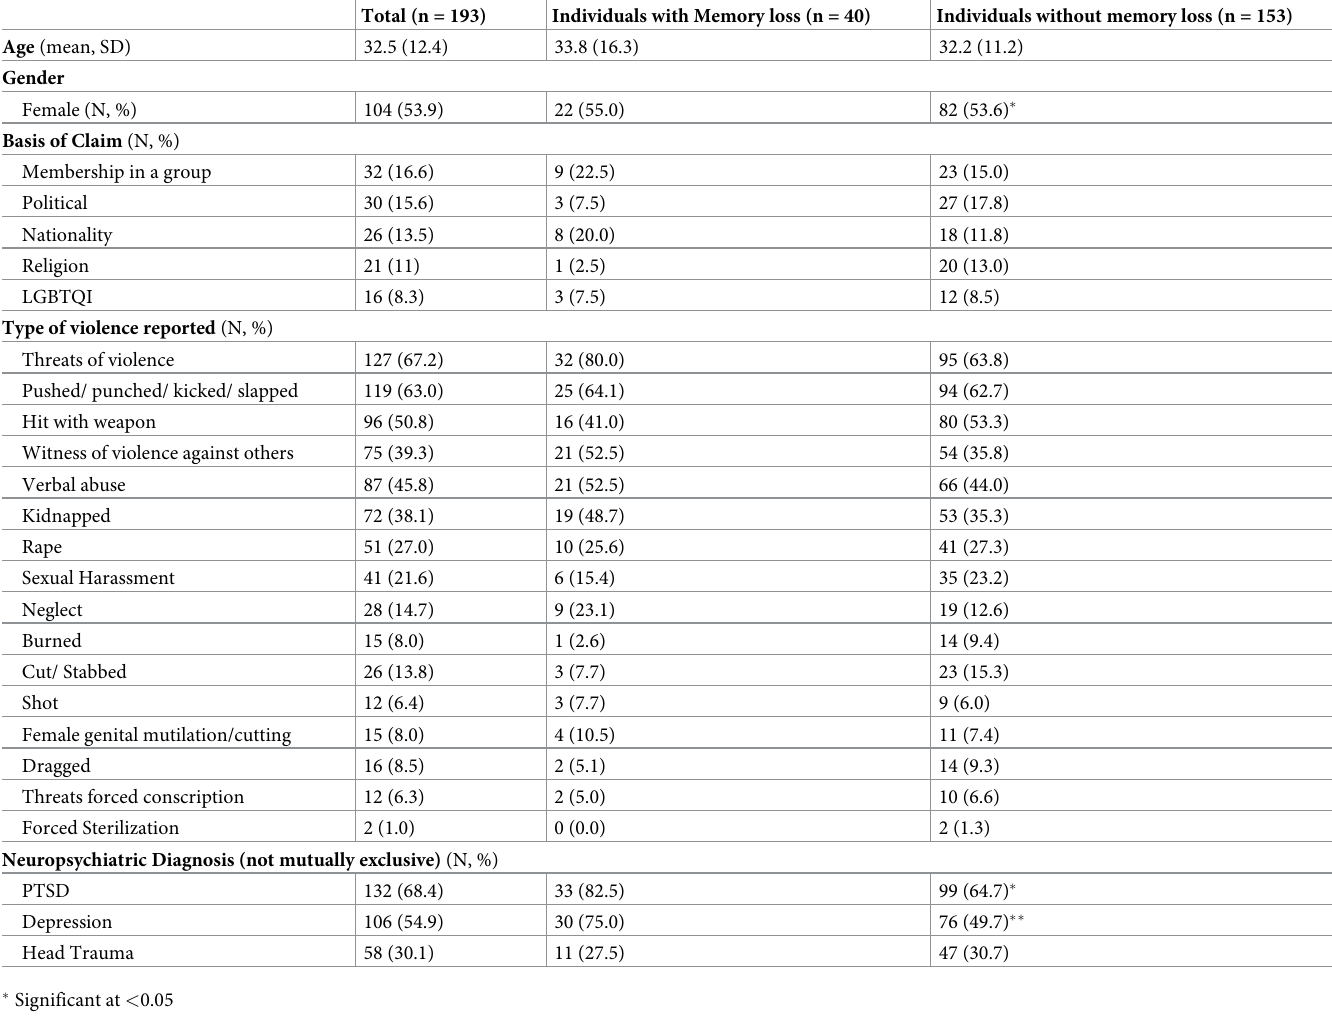
Table 2. Social demographic characteristics of sub-sample, N = 193.